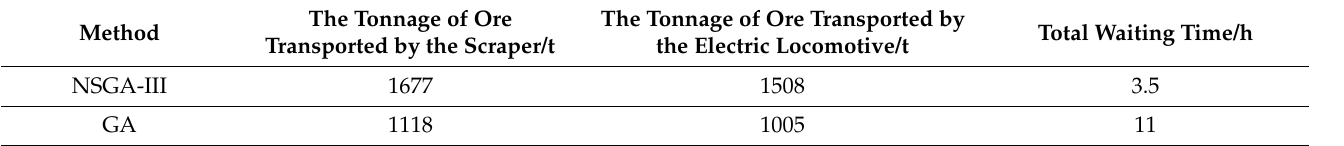
Figure 7. Change curve of the target value with evolutionary generation. Table 10. Comparison of the two schemes.